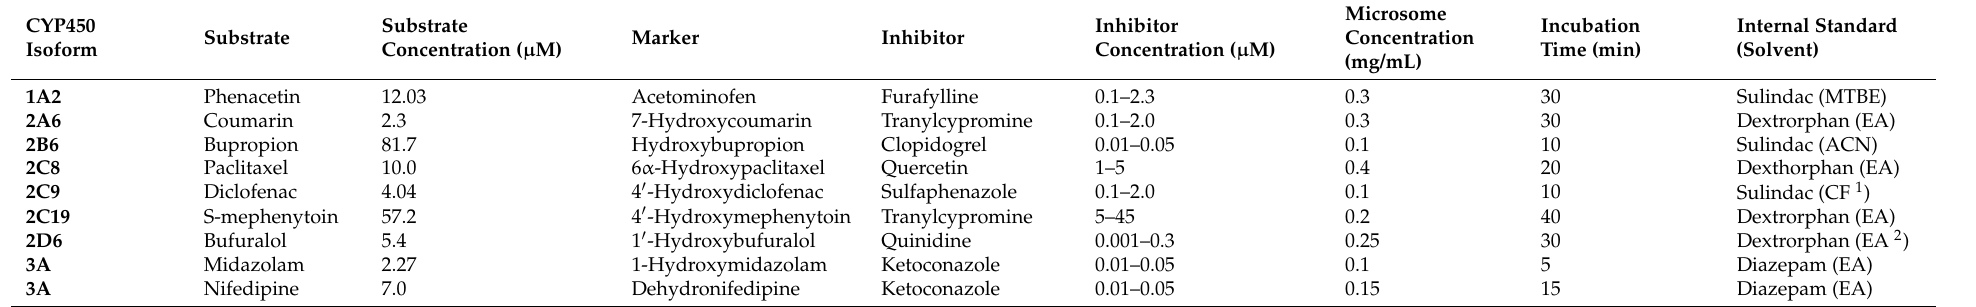
Table 1. Conditions of the in vitro CYP450 metabolism inhibition